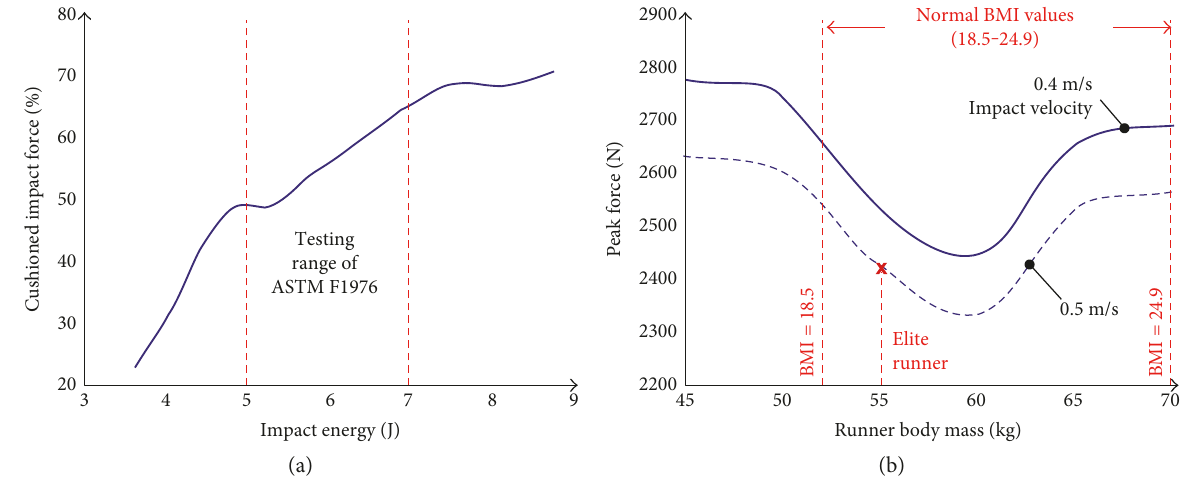
Figure 4: (a) % cushioned force as a function of impact energy. (b) Body mass and strike velocity dependent